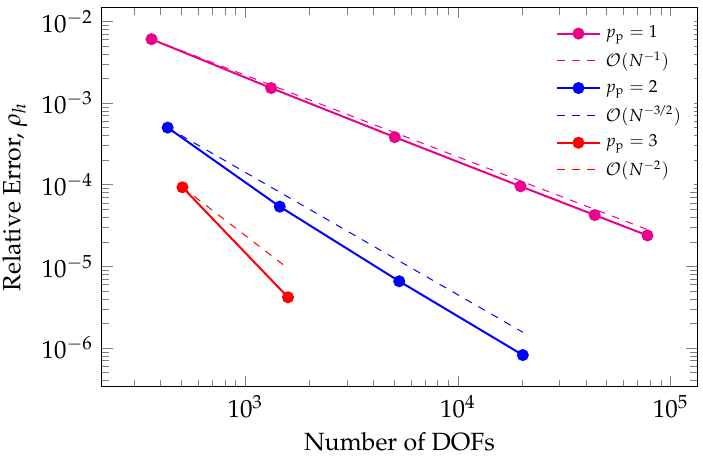
Figure 6. Convergence rates in the relative L 2 norm of pressure, for three different polynomial